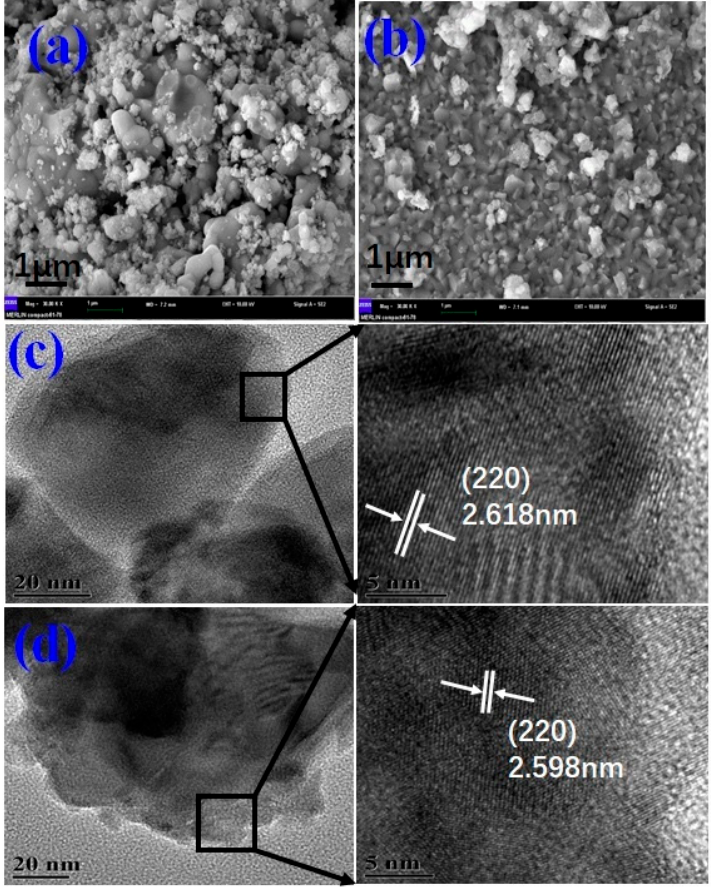
Figure 2. The SEM and HRTEM images for prepared undoped ( a , c ) and Zn-doped CCTO ( b , d ).